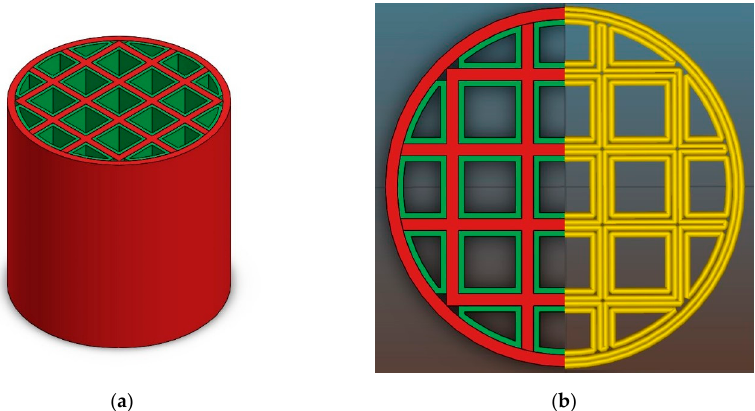
Figure 8. CAD model of a honeycomb consisting of two different materials ( a ) and visualization of the machine data ( b ).